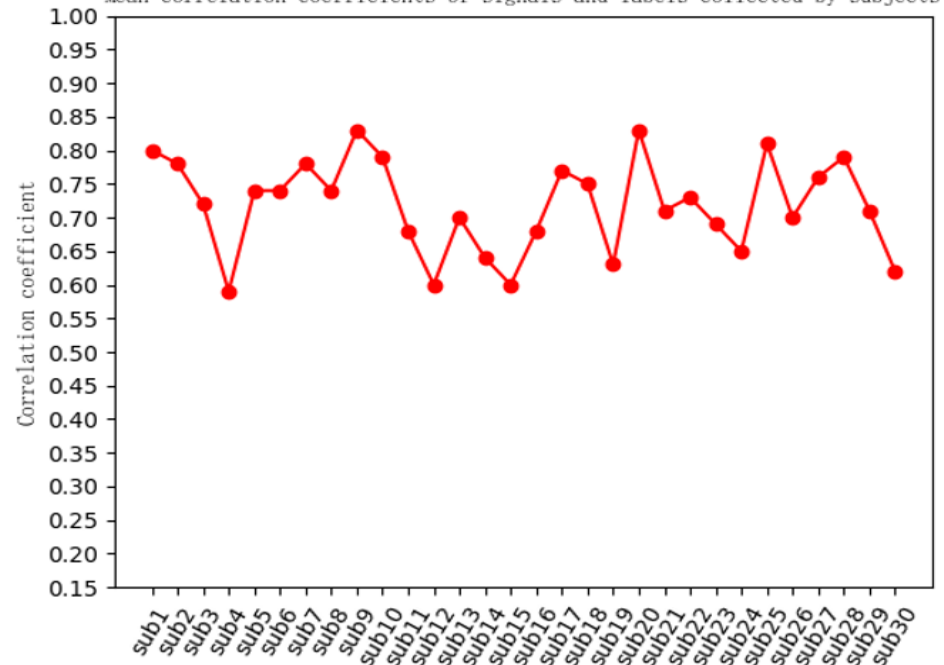
Figure 7. Overall mean correlation coefficient of different subjects.